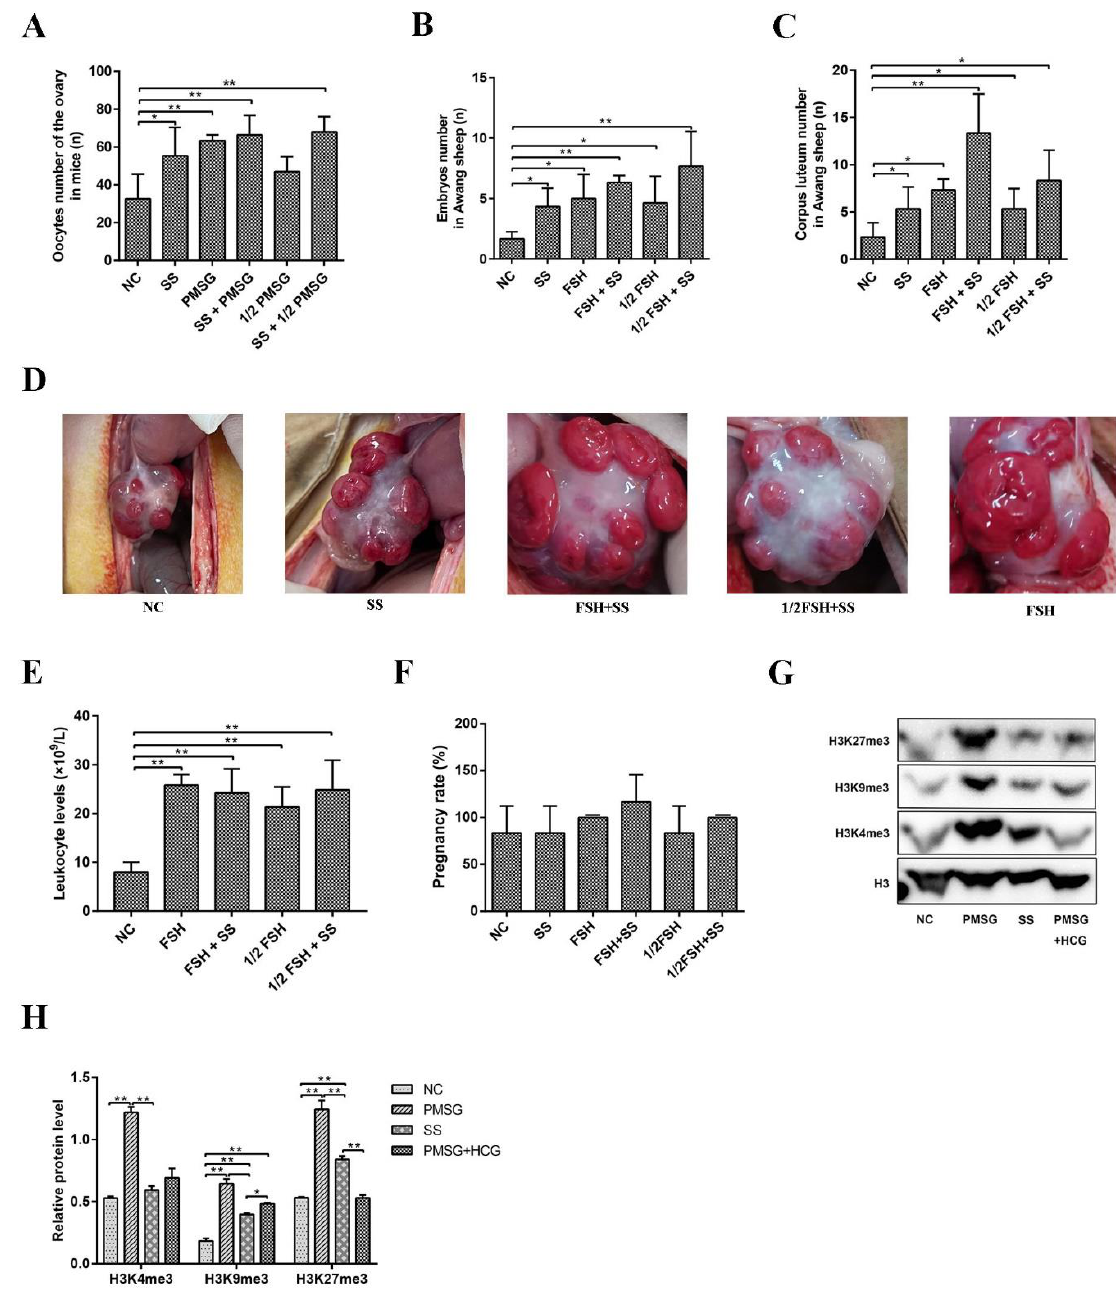
Figure 6. Effects of sodium salicylate and FSH/PMSG on superovulation. ( A ) Ovulation in mice was affected by the combination of sodium salicylate (SS) and PMSG ( n = 4). ( B , C ) Influence of the combination of sodium salicylate (SS) and FSH on the number of embryos ( B ) and corpora luteum ( C ) in Awang sheep ( n = 4). ( D ) Sodium salicylate (SS) and FSH increased the level of leukocytes in the blood of Awang sheep in the different treatment groups ( n = 4). ( E ) Different treatments affected the appearance of the ovarian corpus luteum in Awang sheep ( n = 4). ( F ) Pregnancy rate of Awang sheep. Two embryos were transferred to each sheep ( n = 6). ( G , H ) SS induced weaker histone methylation levels than those with PMSG. * p < 0.05, ** p <